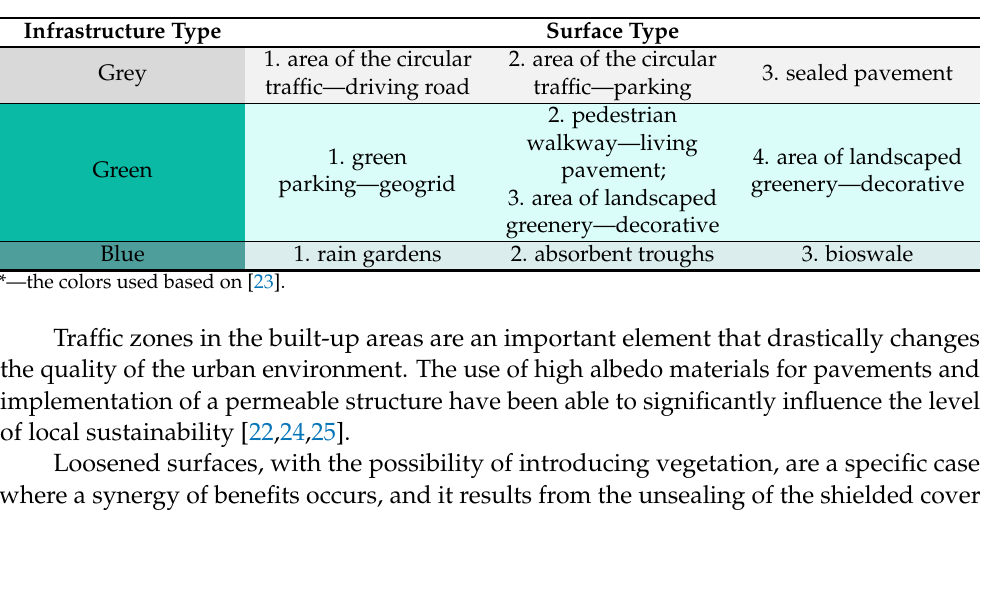
Table 1. Grey–green–blue infrastructure types used in design concept